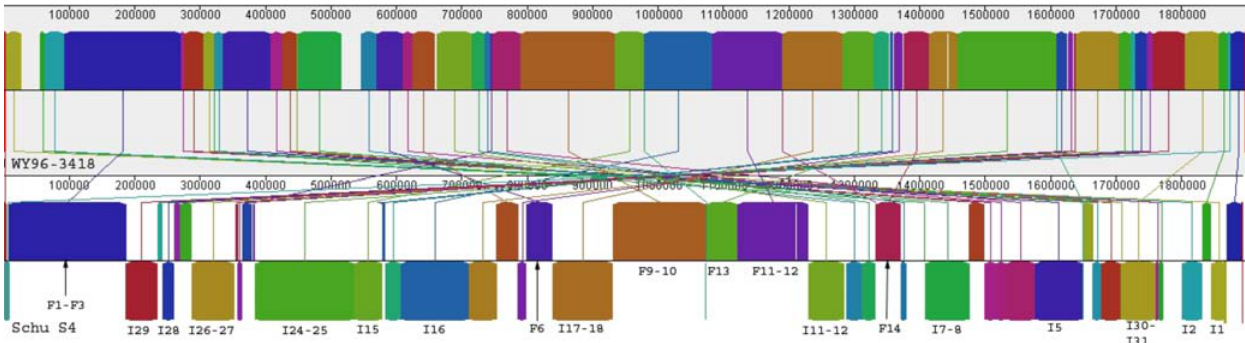
Figure 2. Mauve comparison of the WY96 (top) and Schu S4 (top) (bottom) genomes. Locally collinear blocks (LCBs) are the same color and size between genomes. Labeled blocks contain groups of genes. Blocks are labeled as forwards (F) and inversions (I) and the numbers correspond to names in the supplementary table (Table S3).